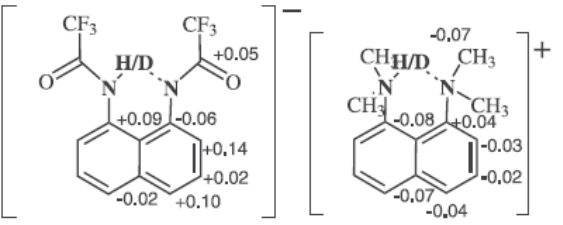
Figure 22. Deuterium isotope effects on 13 C chemical shifts of a proton sponge. Reprinted with permission from Ref. [54]. Copyright 2013 Wiley.